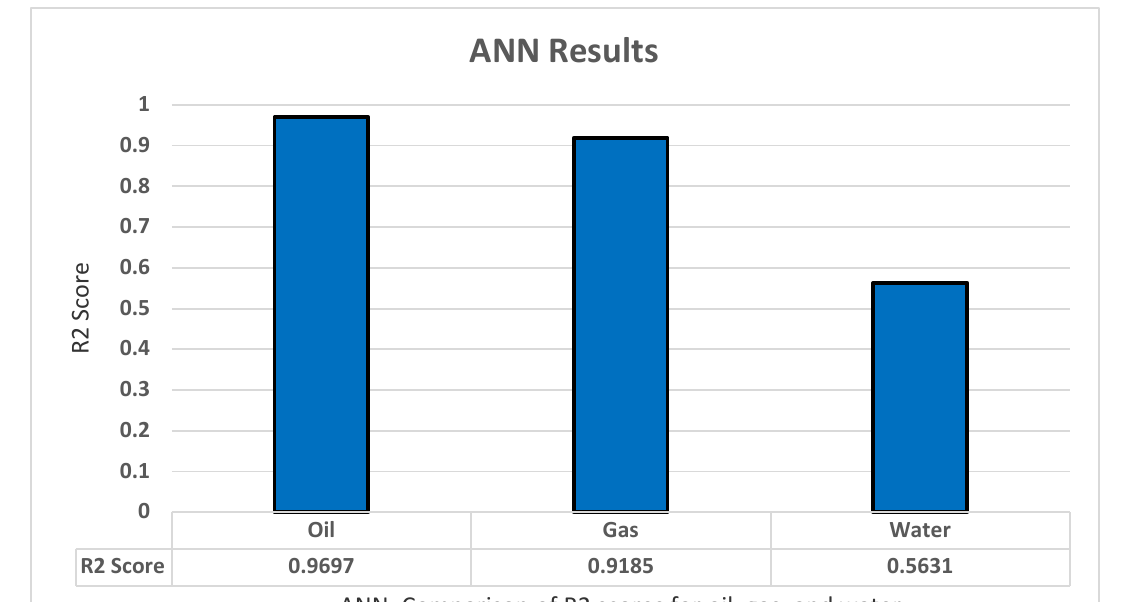
ANN: Comparison of R2 scores for oil, gas, and water Figure 10. ANN’s R2 score results.